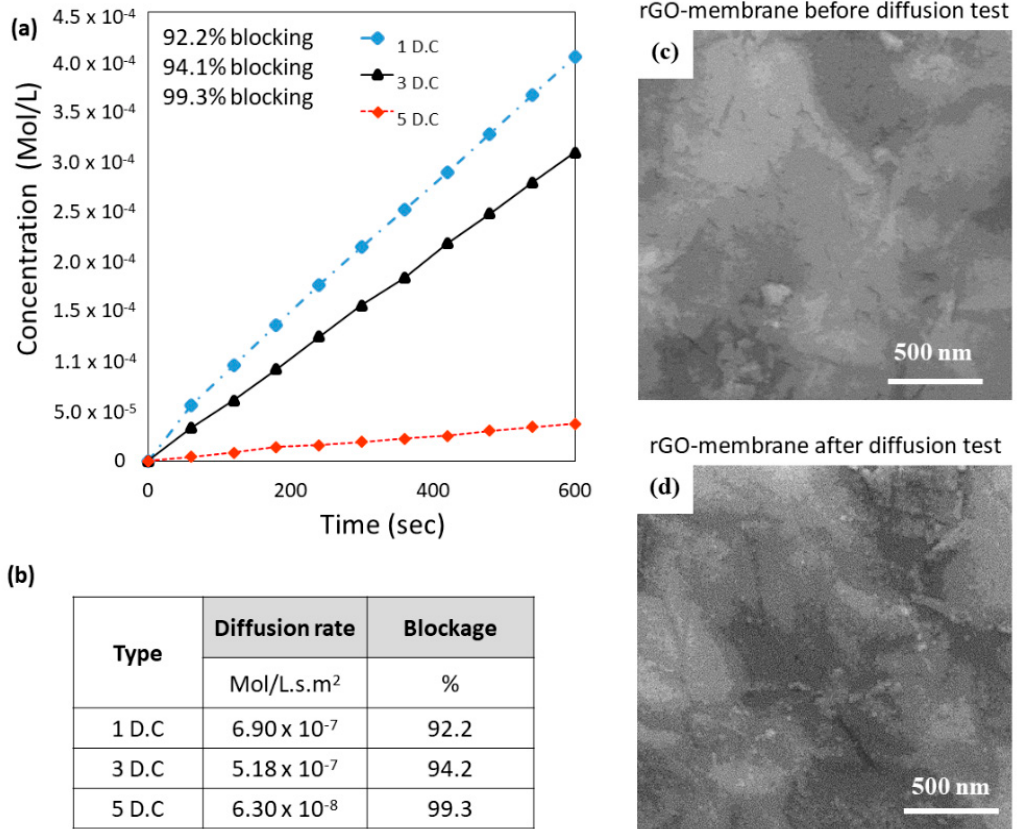
Figure 8. Di ff usion study and surface morphology of the rGO-2min PT-PES membrane: ( a ) The results of the di ff usion study for the 1, 3, and 5 spin-coating deposition cycles (D.C) of rGO on PES-2 min PT; ( b ) the rate of KCl ion di ff usion through the rGO-2min PT-PES membrane for di ff erent deposition cycles. Surface morphology of the rGO-2min PT-PES membrane ( c ) before and ( d ) after the di ff usion test.